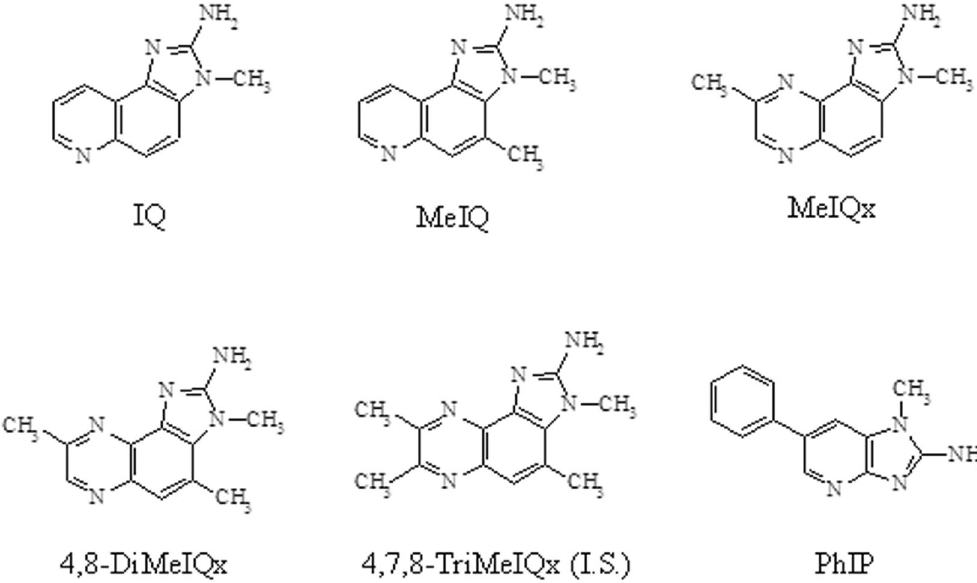
Figure 2. Structures and abbreviations of studied heterocyclic